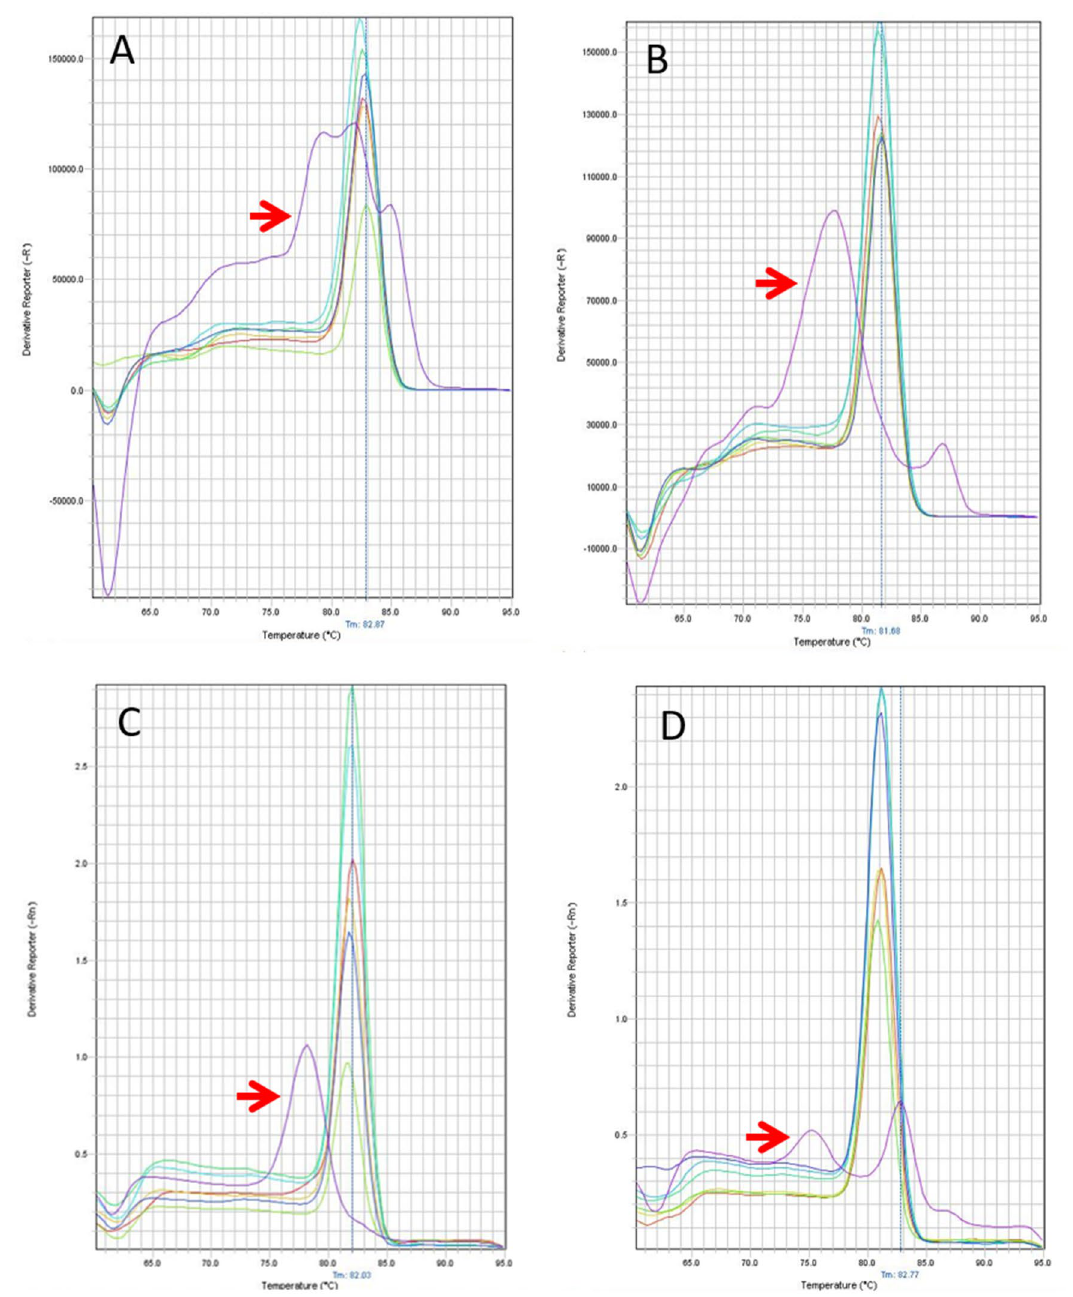
Figure 3. Representation of amplification melt curves after amplification. The melt curves showed a similar pattern for all SARS-CoV-2-positive samples using master mix without UDG activation for the hCOVassay1 ( A ) and hCOVassay2 ( B ) and with UDG activation for hCOVassay1 ( C ) and hCOVassay2 ( D ) primers. The melt curve of the negative samples was quite different from that of the positive samples (arrows). The negative control was from a negative